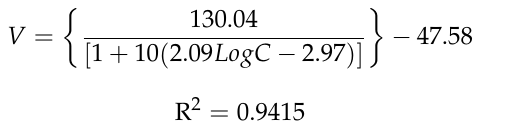
( c ) Figure 4. Copaiba oil cytotoxicity in glioma line cell (C6). Free CP ( a ); copaiba oil in conventional liposome (PC + CP) ( b ); CP in PEGylated liposomes (Phospholipon and lipopeg) ( c ) after exposure for 72 h, at doses 0.2–30 μ g/mL. Statistical significance shown as (*) p < 0.01, (**) p < 0.001 and (***) p < 0.0001 compared with the control (one-way ANOVA followed by Dunnett’s multiple comparison